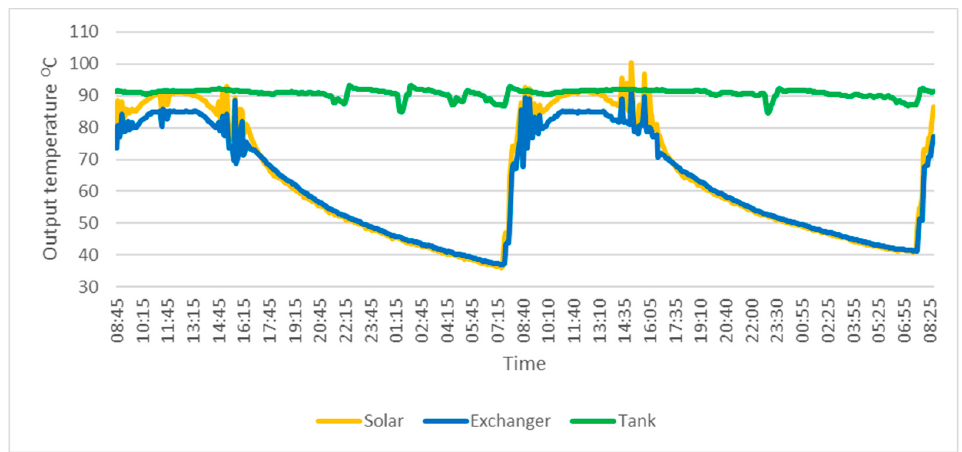
Figure 4. Output temperature of components A, B and C for 24 h.